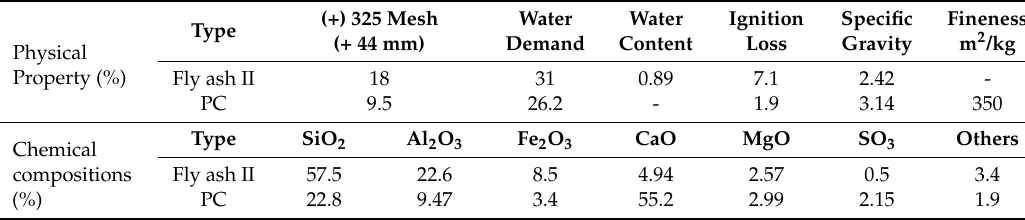
Table 1. Physical properties and chemical compositions of cement and Fly Ash